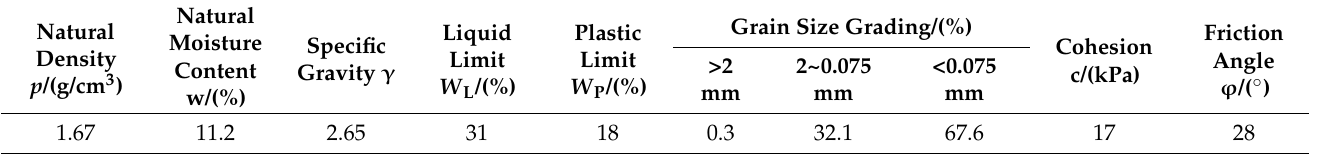
Table 1. Basic physical properties of materials.